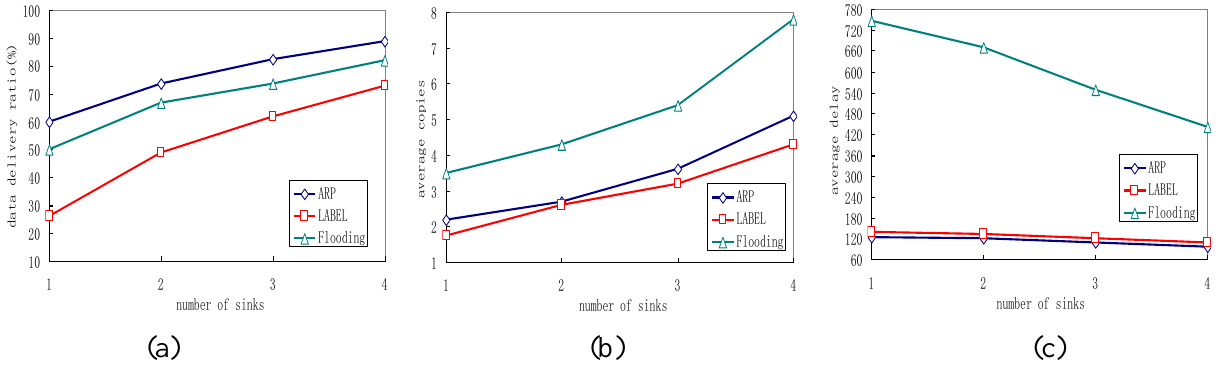
Figure 10. Impact of the number of sink nodes: (a) Average delivery ratio; (b) Average copies; (c) Average